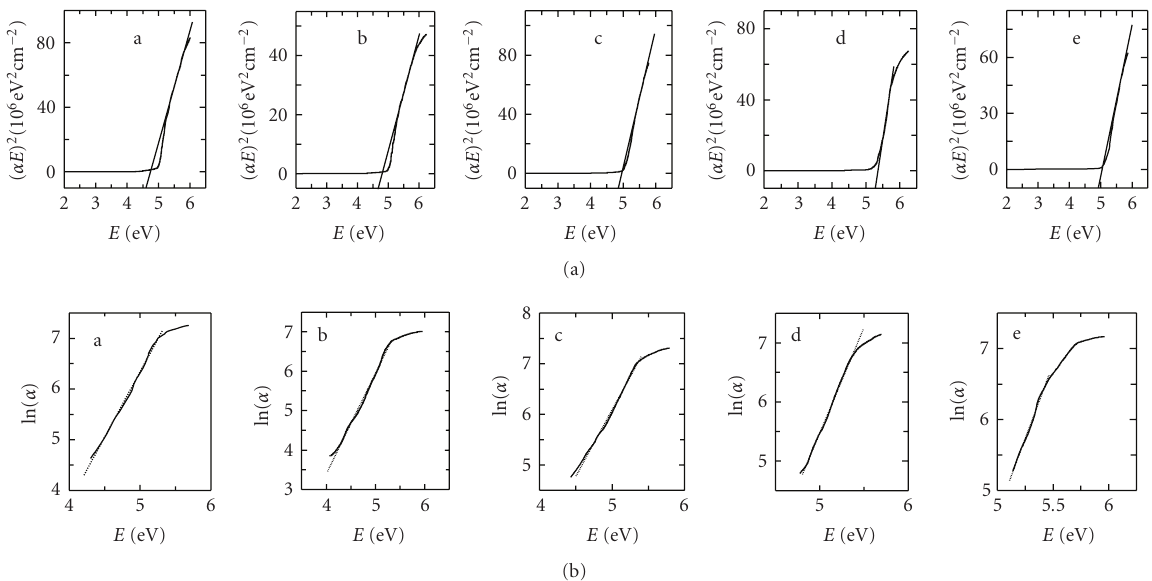
Figure 4: (a) The dependence of ( αE ) 2 on photon energy E (eV) for (a) pure PMMA, (b) blend of (75/25 PMMA/PVAc), (c) blend of (50/50 PMMA/PVAc), (d) blend of (25/75 PMMA/PVAc), and (e) pure PVAc without exposure to radiation. (b) The dependence of (ln α ) on photon energy E (eV) for (a) pure PMMA, (b) blend of (75/25 PMMA/PVAc), (c) blend of (50/50 PMMA/PVAc), (d) blend of (25/75 PMMA/PVAc), and (e) pure PVAc without exposure to light.